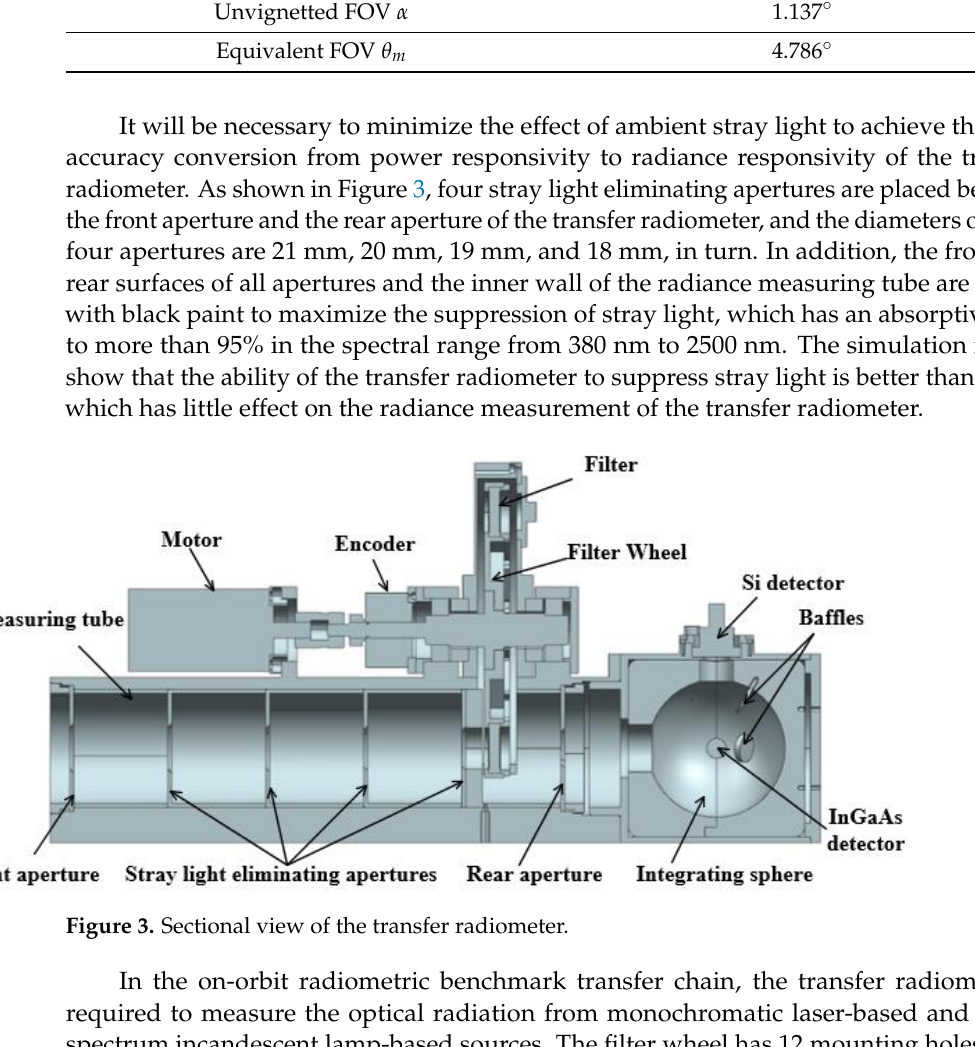
Table 1. Viewing angles of the transfer radiometer.